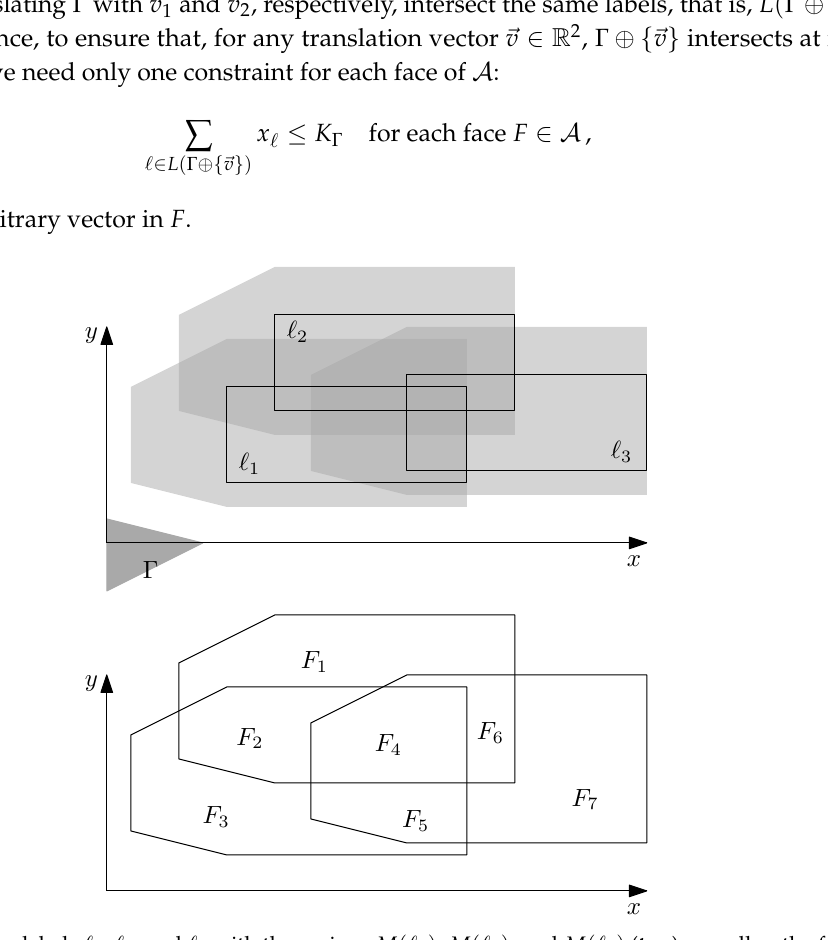
Figure 5. Three labels (cid:96) 1 , (cid:96) 2 , and (cid:96) 3 with the regions M ( (cid:96) 1 ) , M ( (cid:96) 2 ) , and M ( (cid:96) 3 ) ( top ) as well as the faces of the arrangement A resulting from the overlay of M ( (cid:96) 1 ) , M ( (cid:96) 2 ) , and M ( (cid:96) 3 ) ( bottom